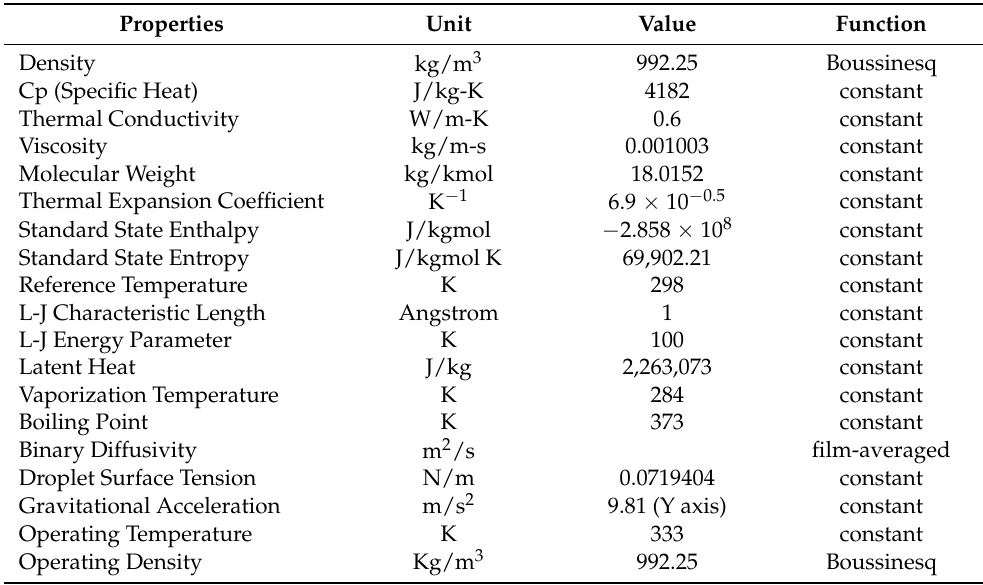
Table 1. Material parameters of the agent (water) applied for the simulations and operating conditions for calculating natural